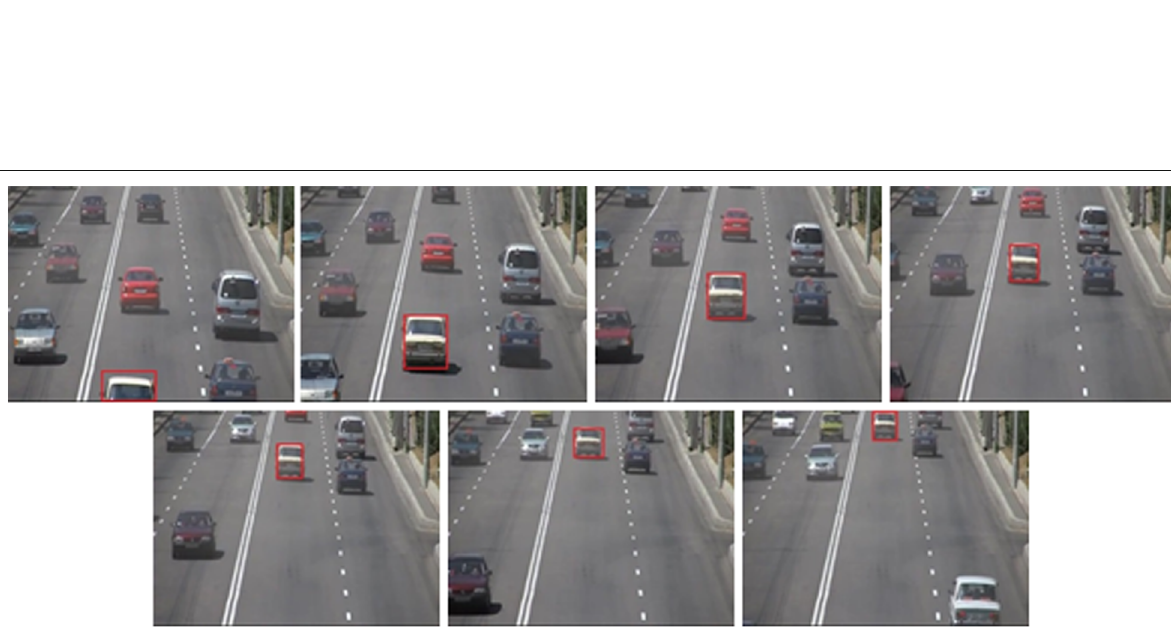
Fig. 22 Operation of proposed algorithm in vehicle tracking at congestion (images are from left to